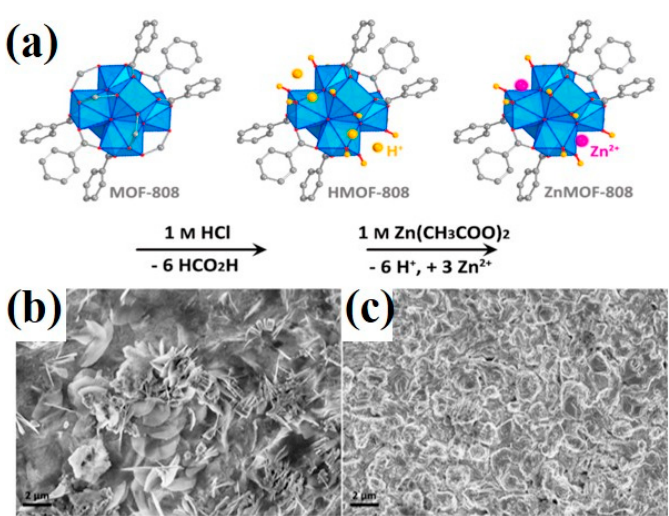
Figure 10. ( a ) Scheme for the post-synthetic of ZnMOF-808. SEM images of the Zn foils after plating/stripping cycles of ( b ) Zn|ZnSO4|Zn cell and ( c ) Zn|WZM|Zn cell [84]. Copyright 2019, Elsevier.